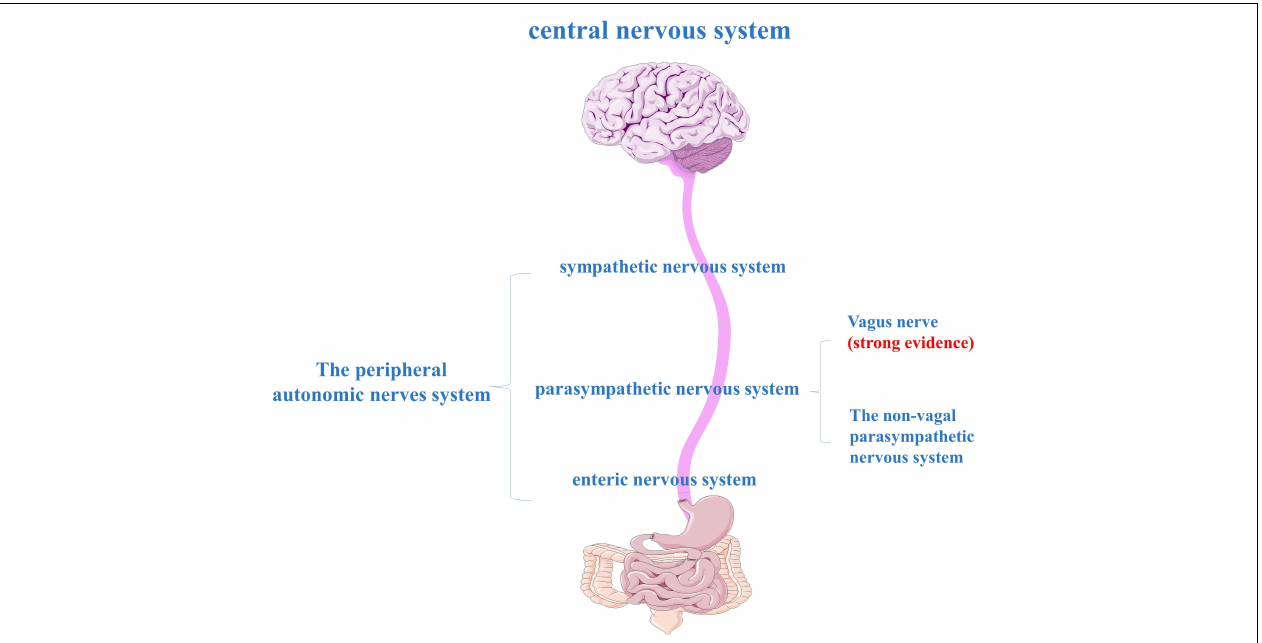
FIGURE 3 | The peripheral autonomic nervous system (ANS) consists of three main parts: the sympathetic nervous system, the parasympathetic nervous system, and the enteric nervous system (ENS).